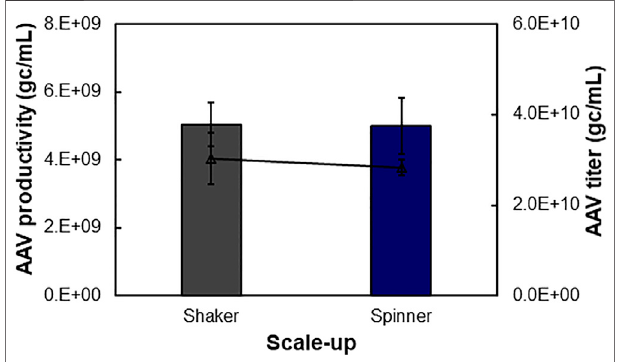
FIGURE 5 | Scalability of suspensive AAV production process. AAV production can be scaled up from 30 to 450 ml in shaker fl asks at 37 ° C and agitation 100 rpm and spinner fl asks at 37 ° C and agitation 70